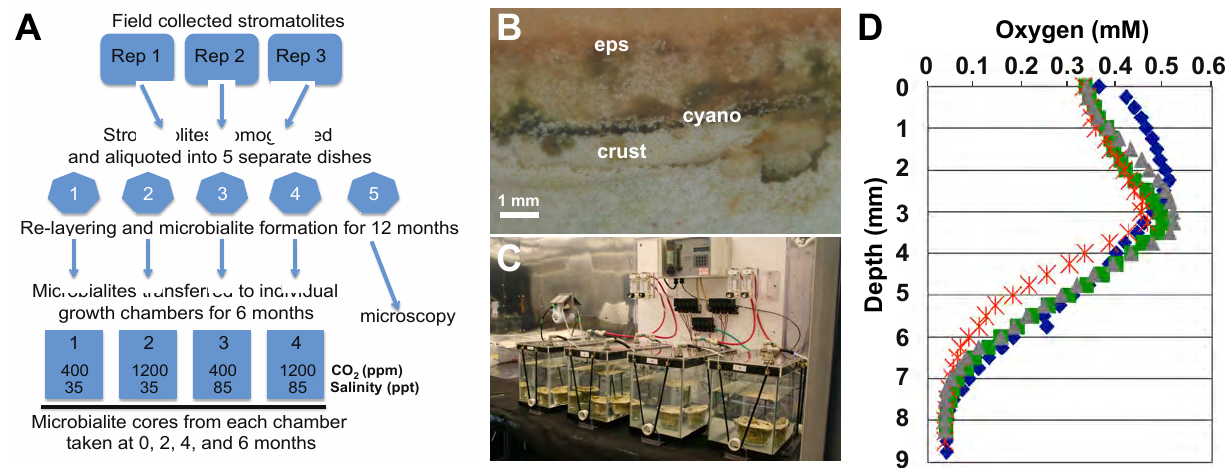
Figure 1. Overview of experimental design, microbialites and environmental manipulation chambers. ( A ) Flow chart depicting the experimental design; ( B ) Cross section of microbialites at the end of the re-layering period (T0) depicting the three primary layers: biofilm layer rich in exopolymeric substances (eps); cyanobacterial (cyano); and aragonite-fused grain crust (crust); ( C ) Independent growth chambers were used to house microbialites and manipulate environmental conditions; ( D ) Oxygen depth profiles of microbialites at